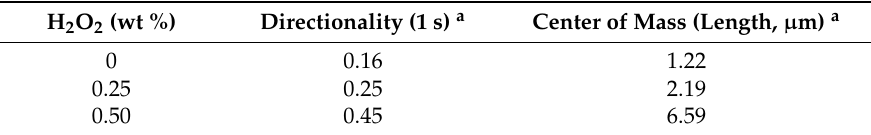
Figure S1: 1H-NMR spectra of 3-(11-hydroxyundecanyl)-1-vinylimidzalium bromide before (black line) and after (red line) esterification reaction with α -bromoisobutyryl bromide. Figure S2. Zeta-Potential values of NP-Br, NP -g- PNIPAM and PtNP@ NP -g- PNIPAM. Figure S3 Size of NP-Br, NP -g- PNIPAM and PtNP@ NP -g- PNIPAM measured by